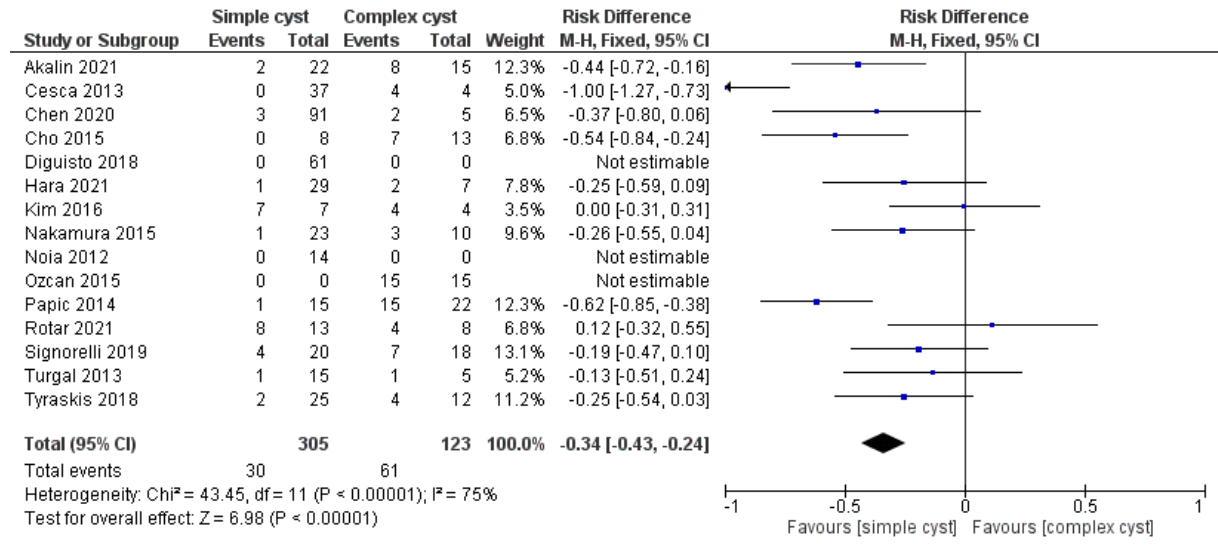
Figure 2. Forest plot comparing the risk of complication in simple cysts vs. complex cysts.